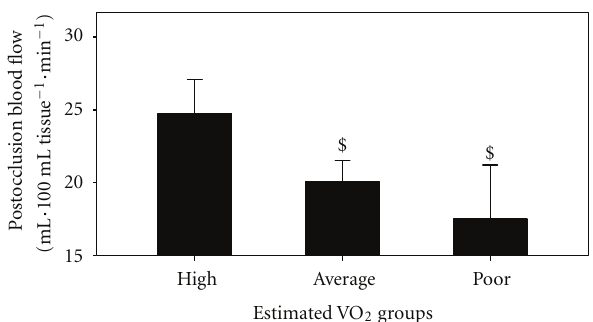
Figure 2: Estimated VO 2 relationship with DBP in the females (a) ( r = − 0 . 3; P = 0 . 005) and males (b) ( r = − 0 . 2; P = 0 . 03).